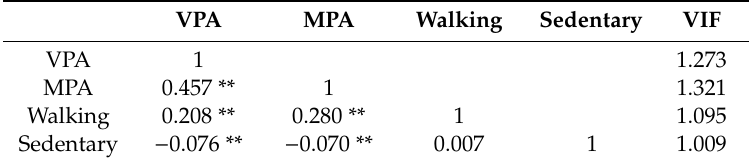
Table 2. Correlation for di ff erent intensity categories and